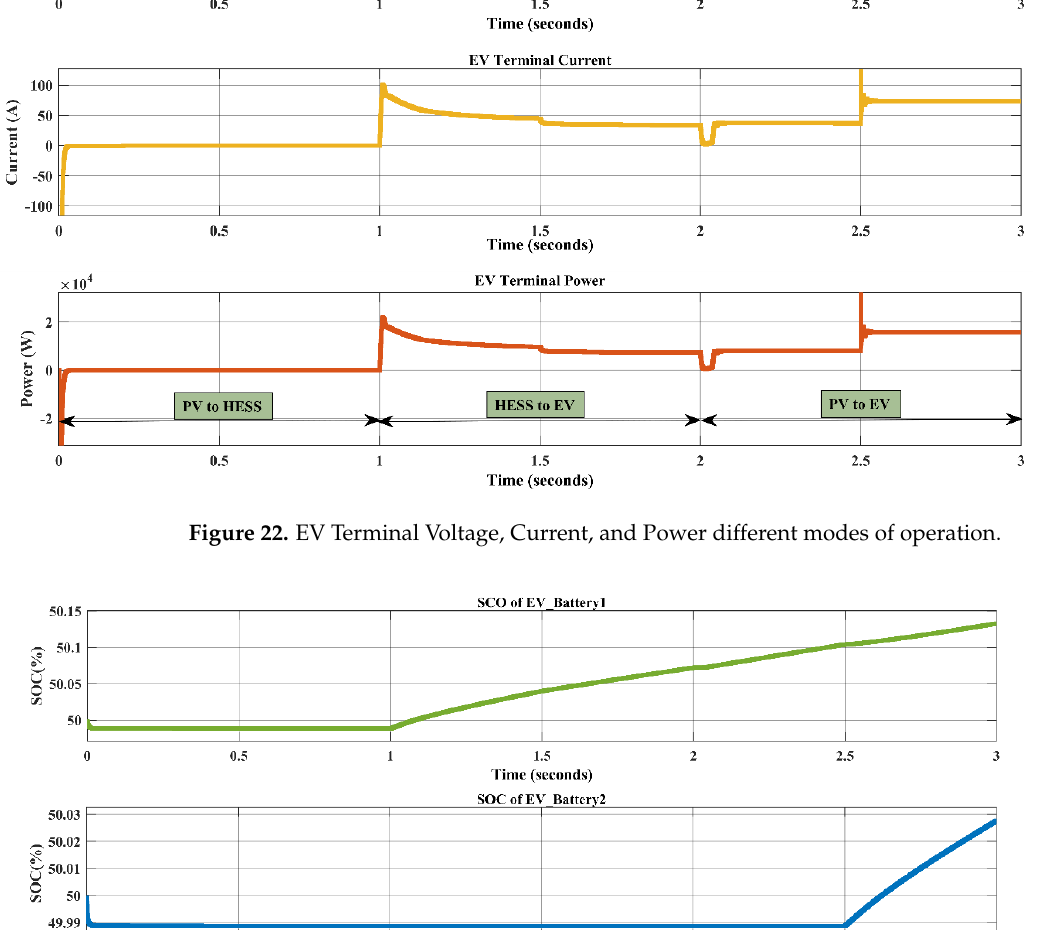
Figure 23. You can charge two vehicles at a time at an Extreme Fast charging station.